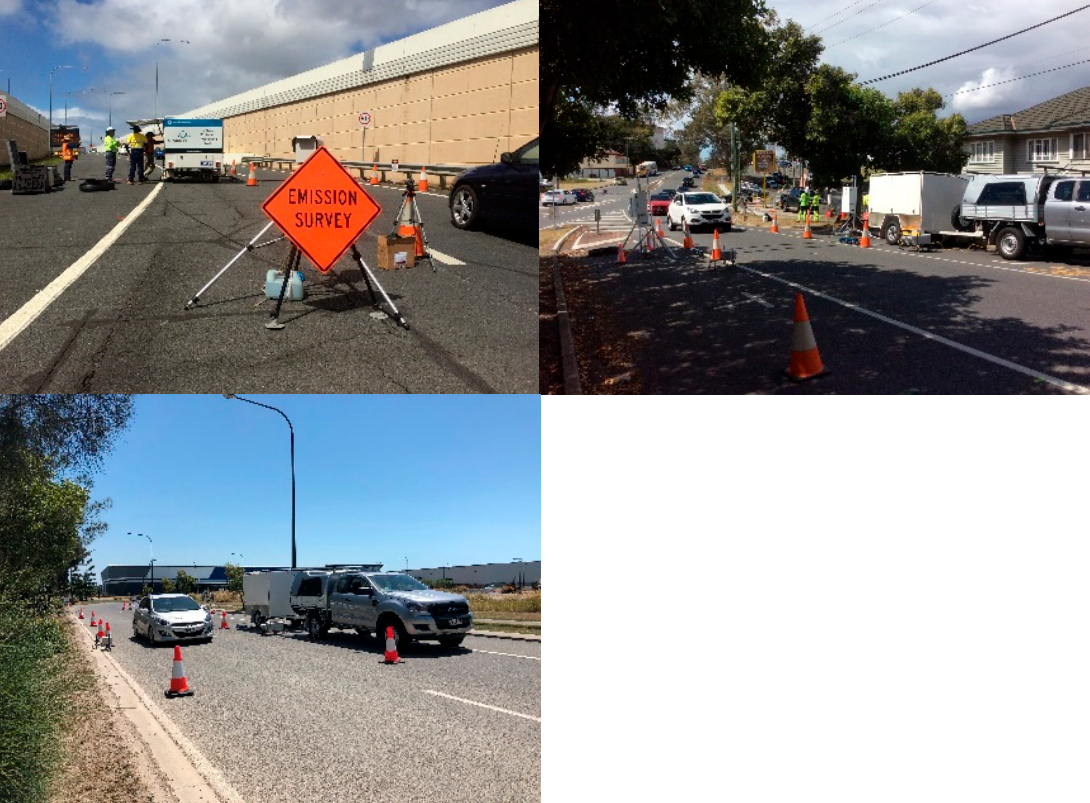
Figure 1. On-road emission test sites in Brisbane, Australia, from left to right and down: freeway on-ramp (FWY) (4–5 September 2018), a heavily trafficked urban road (URB) (6–7 September 2018), and a commercial road in an industrial area (COM) (20 February 2019).